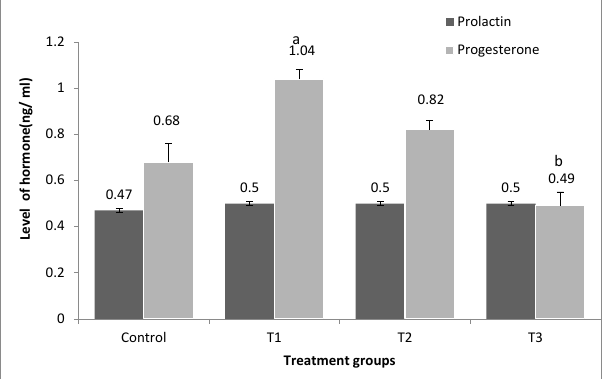
Figure 9. Effect of pomegranate peel and garlic powder separately or in combination on serum prolactin and progesterone levels of does. Values are presented as means ± SE (n = 5 litters). T1; pomegranate peel 3%, T2; garlic 3%, and T3; pomegranate peel 1.5% + garlic 1.5%. a Significant difference as compared to control, b Significant differences as compared to T1 ( p < 0.05).